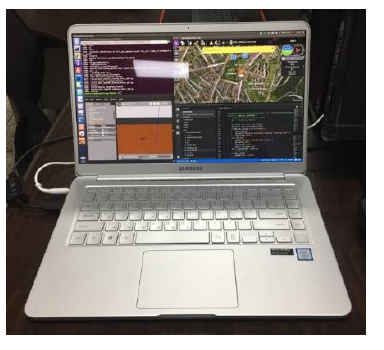
Figure 8. Overview of the GCS.